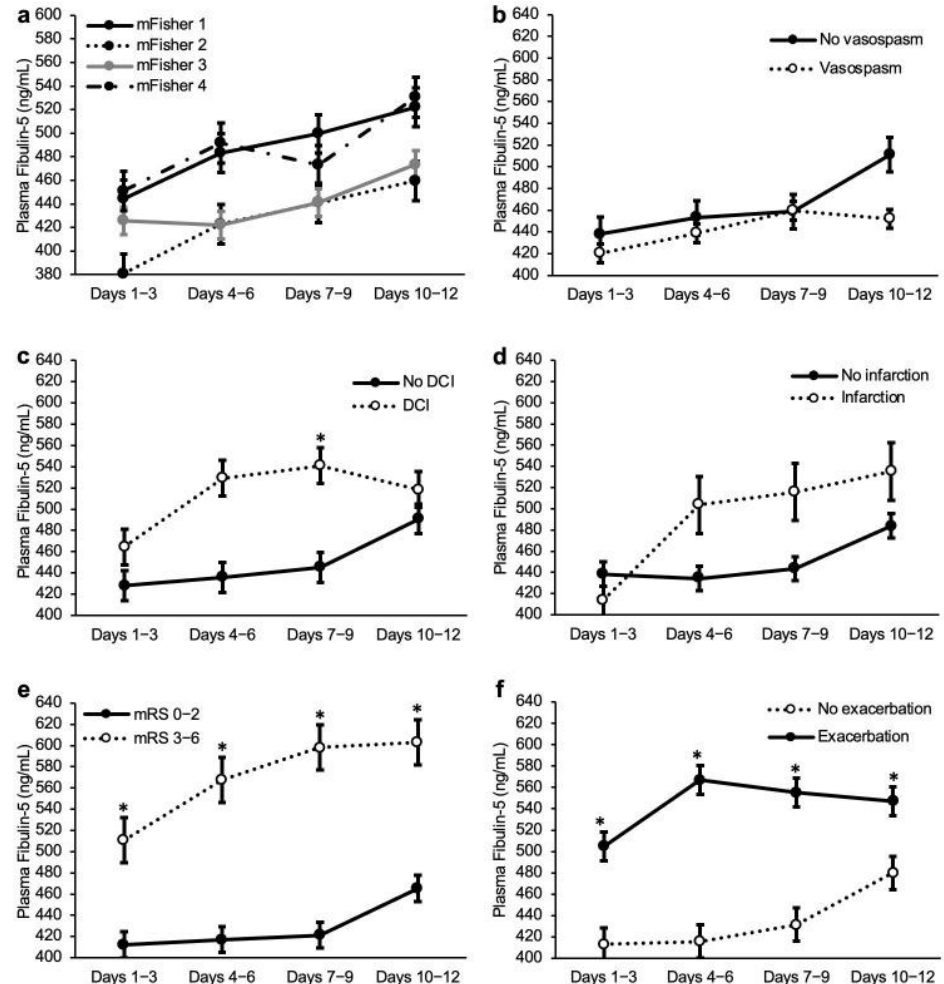
Figure 3. Chronological changes in the plasma fibulin-5 levels in patients with, at admission, World Federation of Neurological Surgeons grades I-III of a subarachnoid hemorrhage. Comparison among the modified Fisher grades ( a ), between the patients with and without an angiographic vasospasm ( b ), a delayed cerebral ischemia (DCI); ( c ), or a delayed cerebral infarction ( d ), between the 90-day modified Rankin scale (mRS) 0–2 and 3–6 ( e ), and between patients with and without a neurological exacerbation ( f ). Data, a mean ± standard error of the mean. * p < 0.05, Mann-Whitney U test.